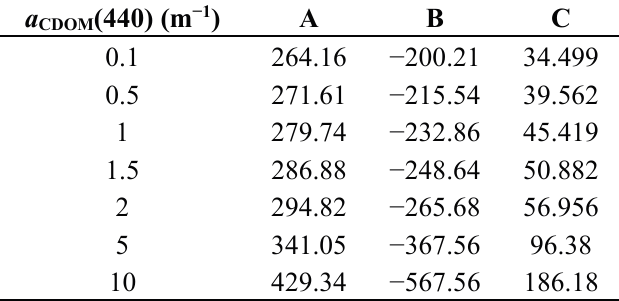
Table 4. Coefficients of the second order polynomial regression CBAChl 2 ++= xx-a